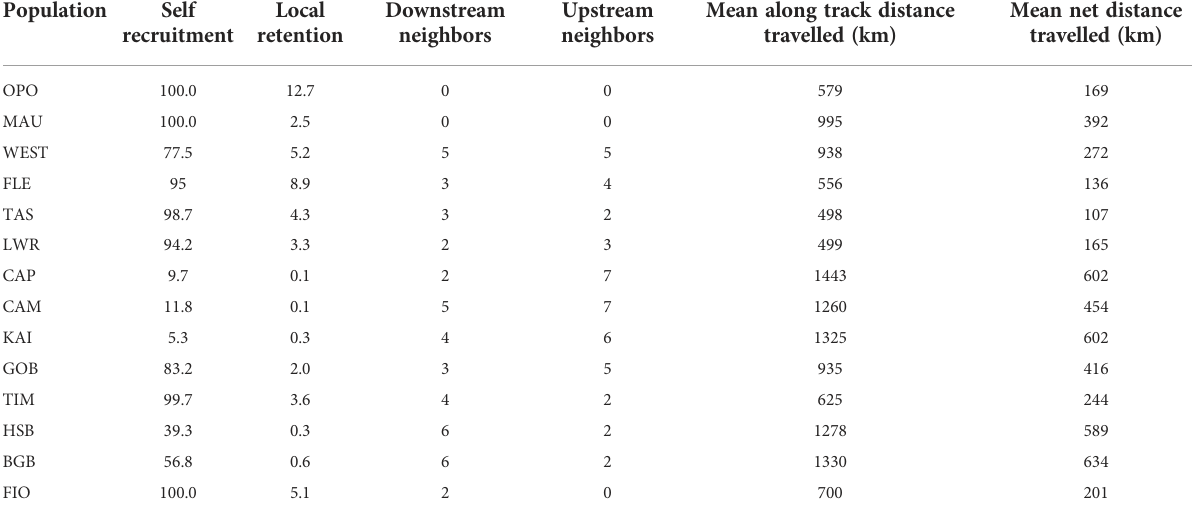
TABLE 2 Network and dispersal statistics for each population. Population Self Local recruitment